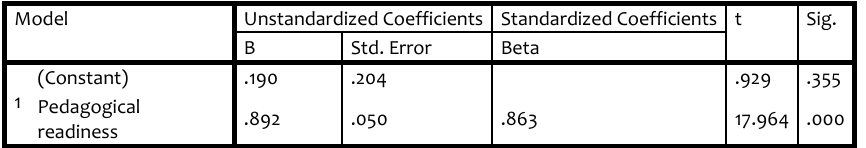
Unstandardized Coefficients Standardized Coefficients